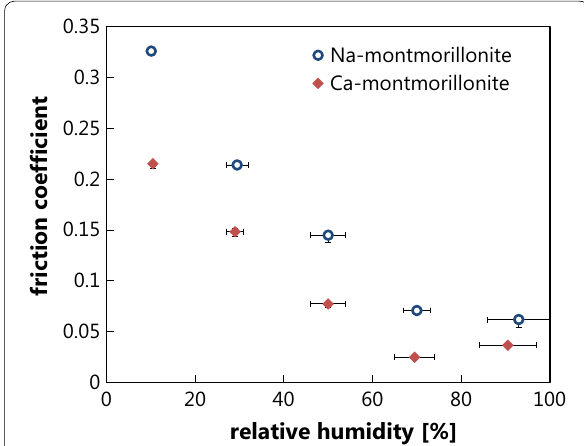
Fig. 6 Friction coefficient plotted as a function of relative humidity. The error bars for relative humidity were calculated from temperature variations within the sample holder during the experiments. Open circles represent data for Na-montmorillonite and filled diamonds are data for